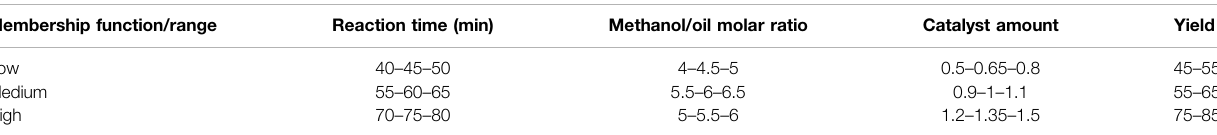
allocated for sample training, 15% samples used for validation, and 15% of samples engaged for testing. Utilizing the presented experimental data, the Levenberg – Marquardt (LM) ANN fi tting